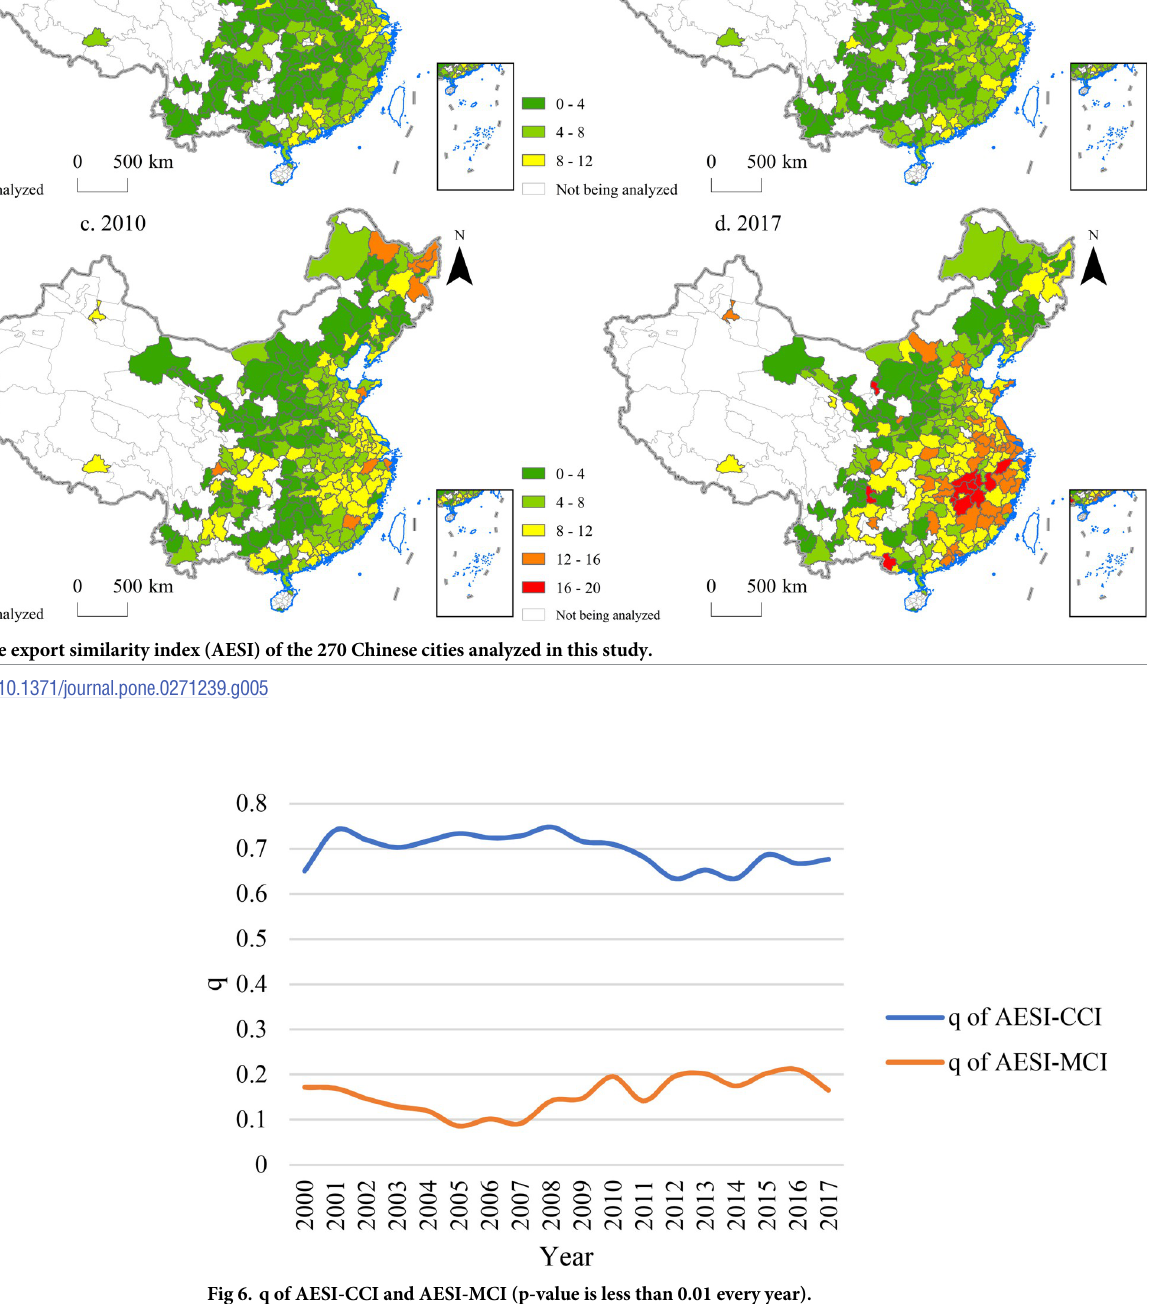
PLOS ONE | https://doi.org/10.1371/journal.pone.0271239 September 15,